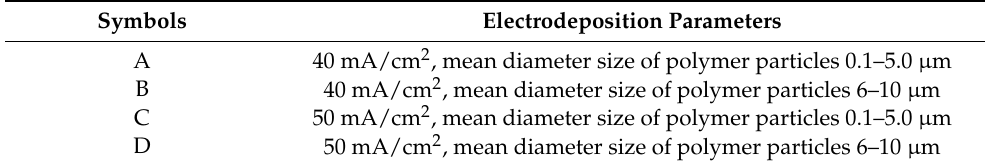
Table 1. Symbols of samples used for